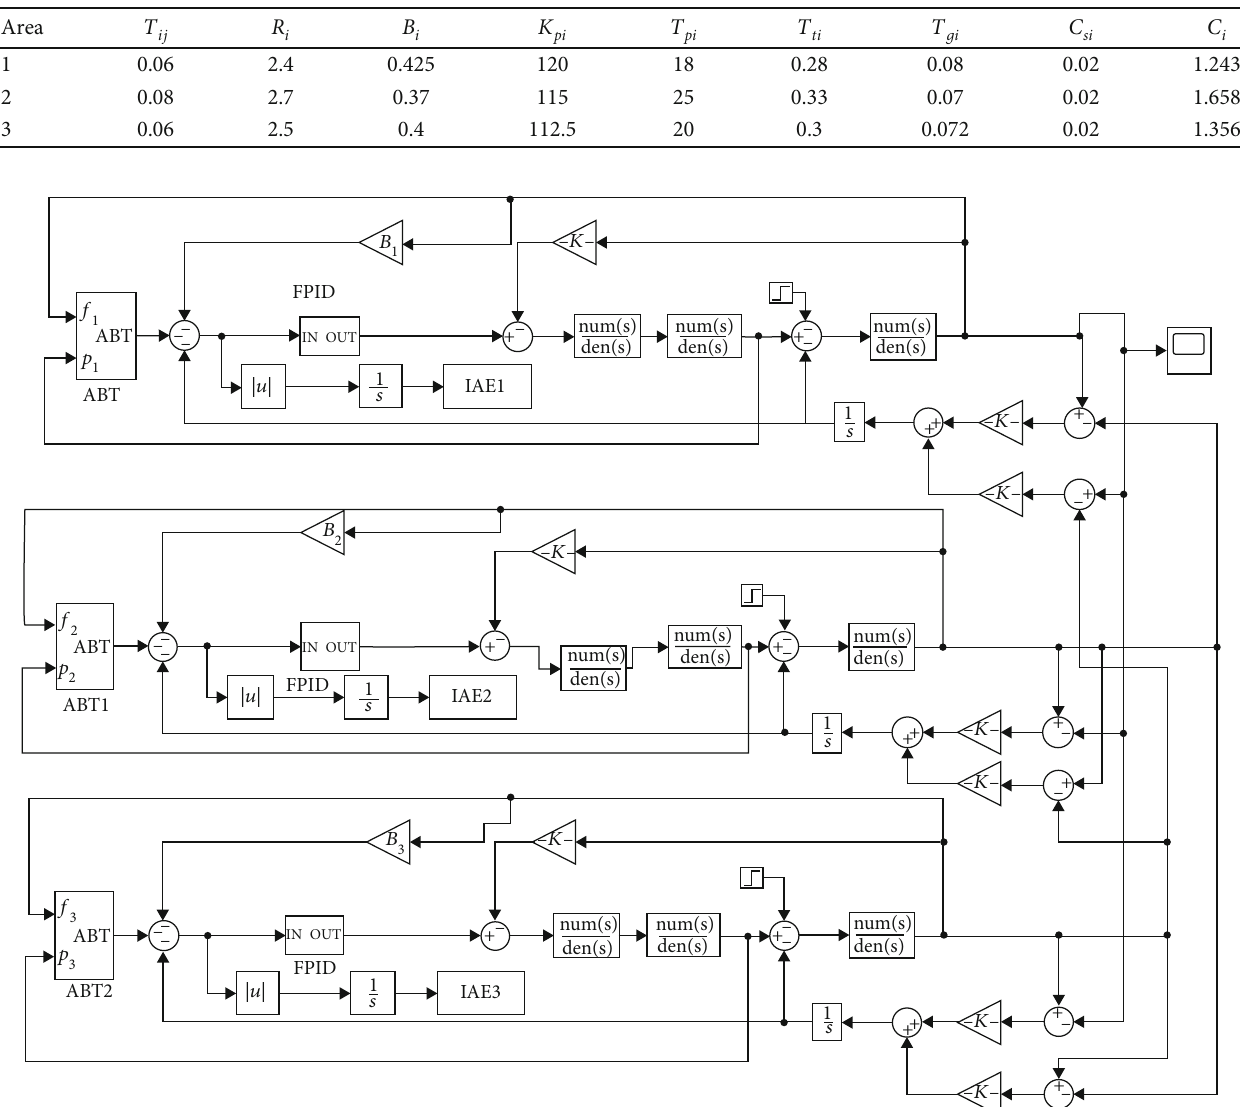
Figure 6: MATLAB Simulink model of the three-area electrical system.